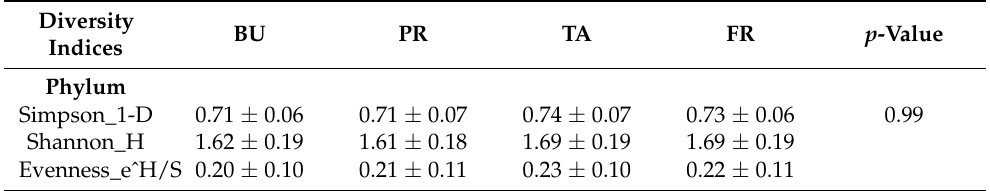
Figure 2. Heatmap showing the relative abundance of bacteria and archaea at each growth stage. Z-score with the scale bar shows the gradient of color saturation representing the relative abundance of the organisms. BU = samples from bulk soil, PR = samples from pretasseling growth stage, TA = samples from tasseling growth stage, and FR = samples from fruiting growth stage. Table 2. Evaluation of evenness and diversity of bacteria and archaea across different growth stages at phylum level.